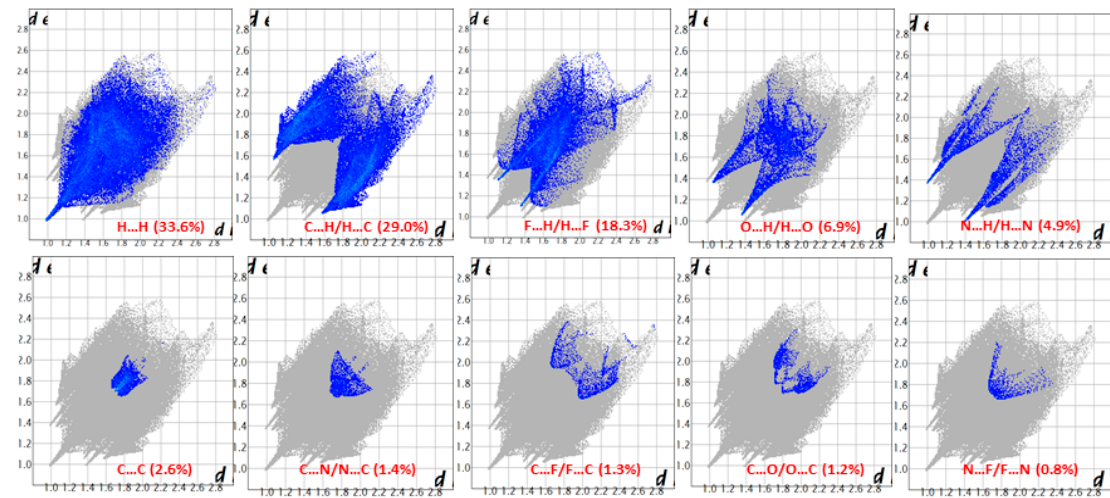
Figure 6. Two-dimension fingerprint plots showing various intermolecular contacts in Compound ( 3 ).